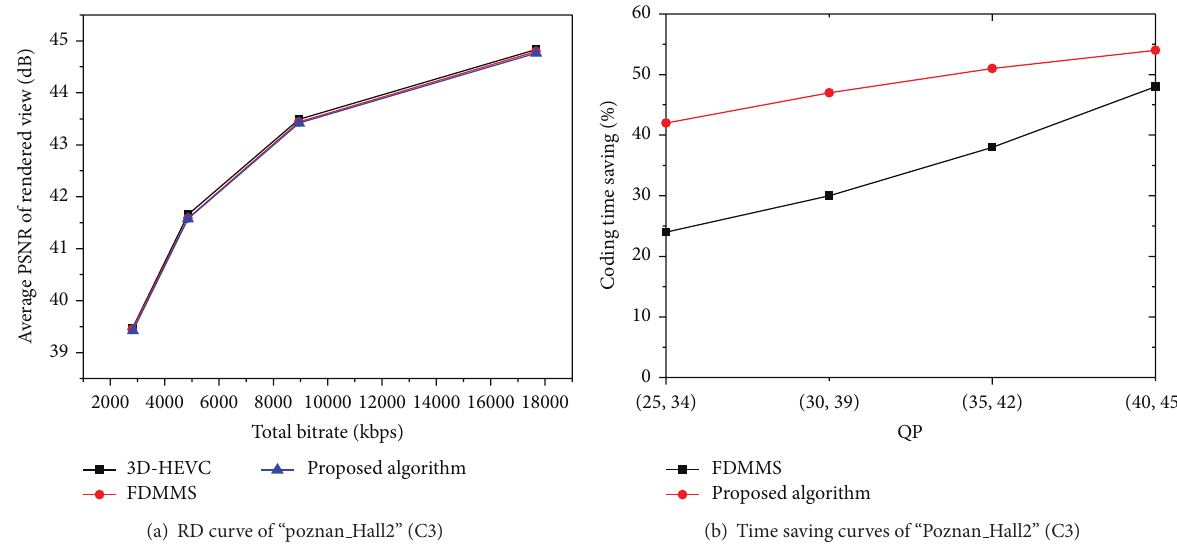
Figure 2: Experimental results of “Poznan Hall2” (1920 × 1088) under different QPs combinations for texture video and depth map (25, 34), (30, 39), (35, 42), and (40, 45).